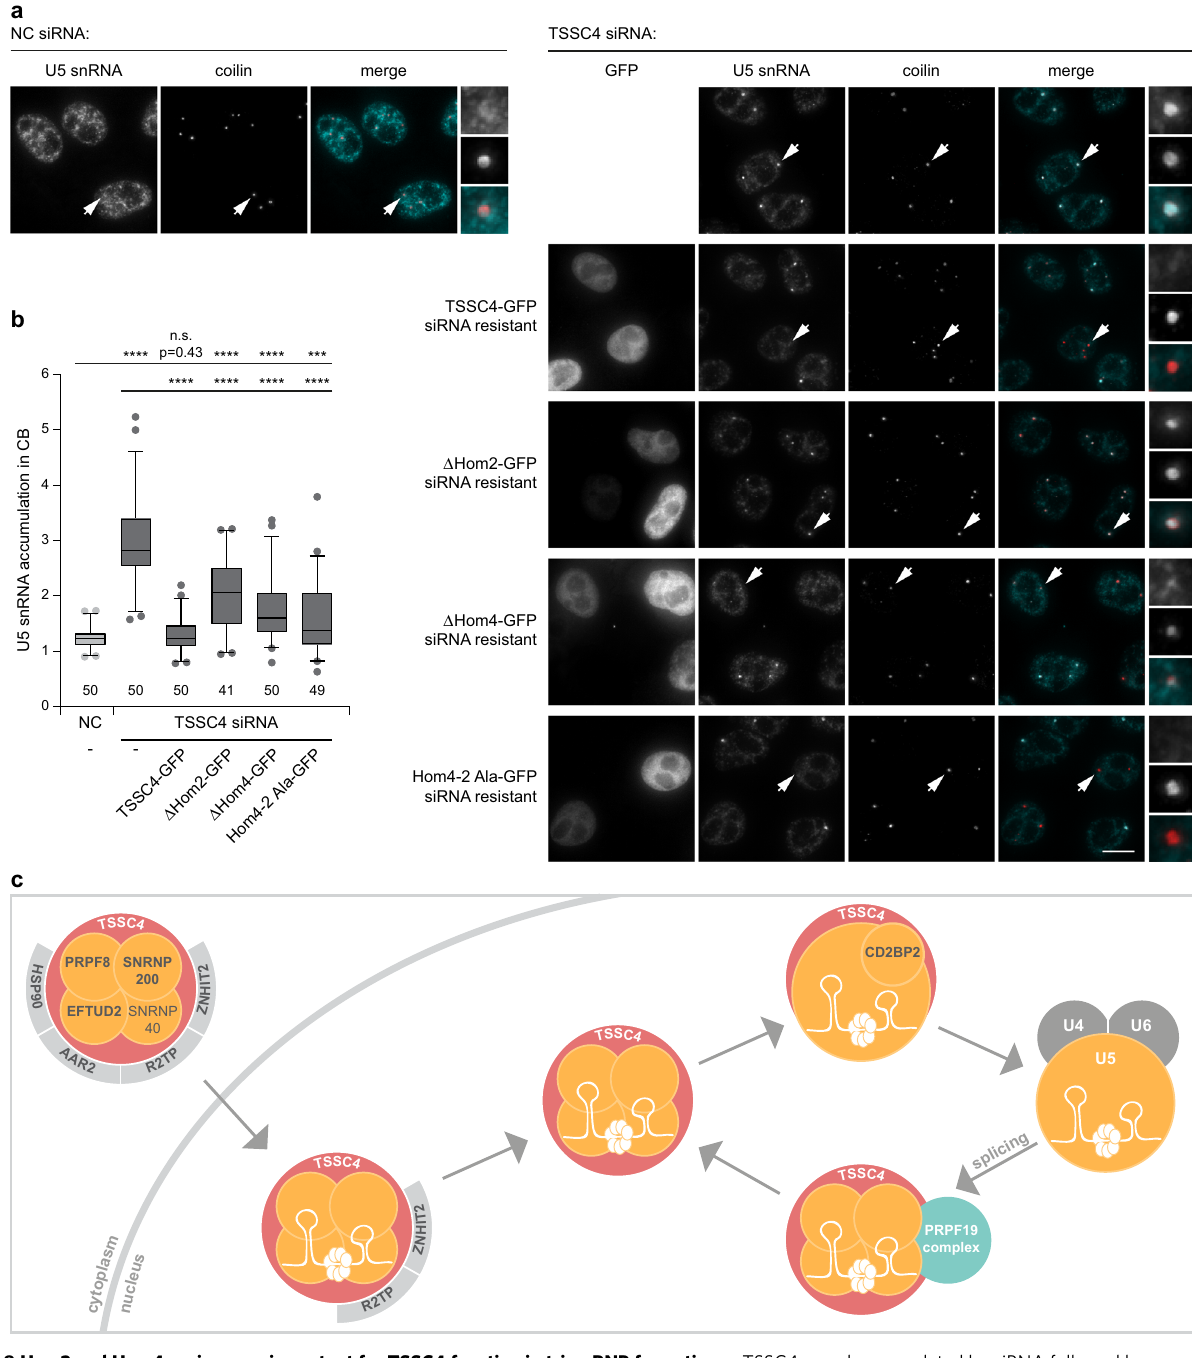
Fig. 8 Hom2 and Hom4 regions are important for TSSC4 function in tri-snRNP formation. a TSSC4 was downregulated by siRNA followed by expression of siRNA-resistant WT TSSC4-GFP, Δ Hom2-GFP, Δ Hom4-GFP, and Hom4-2_Ala-GFP constructs. Tri-snRNP formation was assayed by U5 snRNA localization (turquoise) in Cajal bodies visualized by immunodetection of their marker coilin (red). U5 snRNA localization in Cajal bodies is increased when tri-snRNP assembly is inhibited. Cajal bodies marked by arrows are enlarged fi ve times in insets. Scale bar represents 10 μ m. b Quanti fi cation of U5 snRNA Cajal body accumulation. In situ hybridization signal in the Cajal body was normalized to the average signal in the nucleoplasm. In total, 41 – 50 cells were assayed (see bottom of the diagram for the precise number of assayed cells) and results are shown as a box blot (center line — median; box limits — 1st and 3rd quartiles; whiskers — 5th and 95th percentile). Two lowest and two highest values are depicted as separate dots in each box plot. Statistical signi fi cance was determined by the two-tailed T test. *** indicates P ≤ 0.001; **** indicates P ≤ 0.0001. Original values for box plots are provided in the Source Data fi le. See also Supplementary Fig. 5 for correlation between TSSC4-GFP expression and U5 snRNA Cajal body accumulation. c A model of TSSC4 function in U5 snRNP